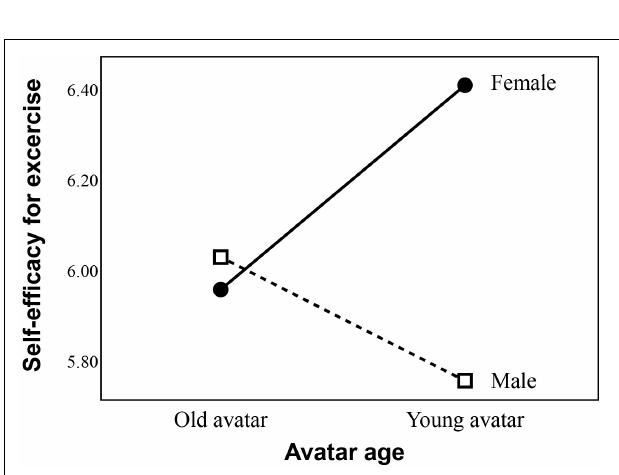
FIGURE 6 | Interaction between avatar age and sex of participants in predicting self-efficacy for